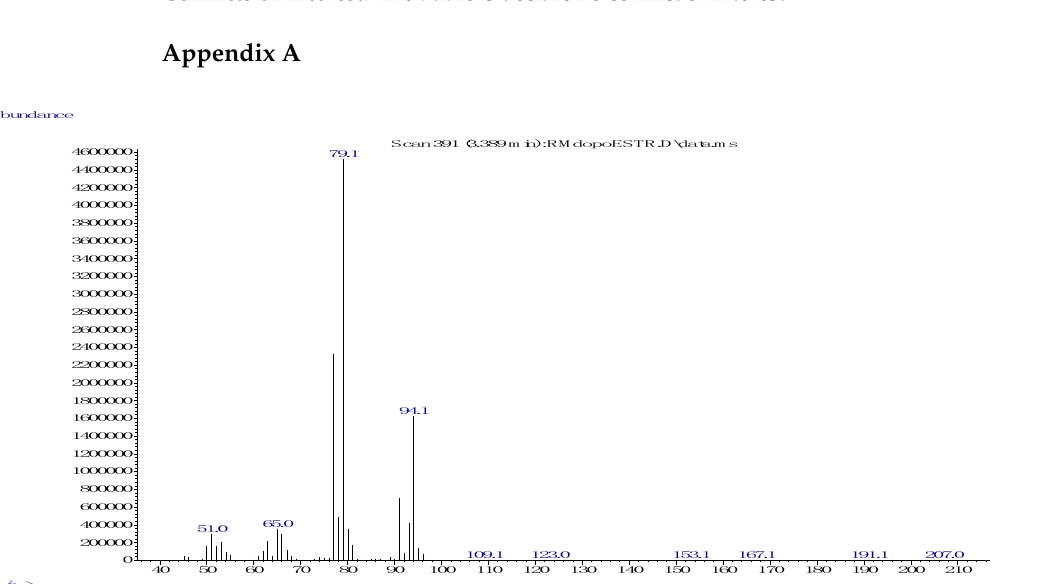
Figure A2 . MS spectrum of 3-ethylidene-1-cyclopentene r.t 3.45.